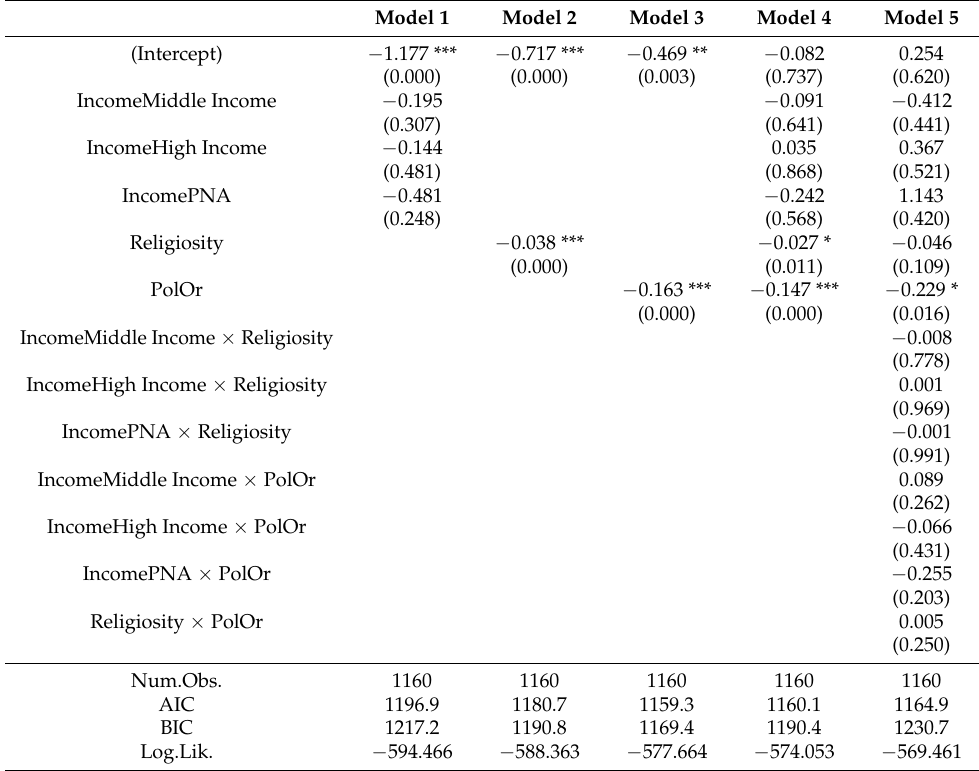
Table 4. The effects of income, religiosity, and political orientation on perception of short-term health risks from air